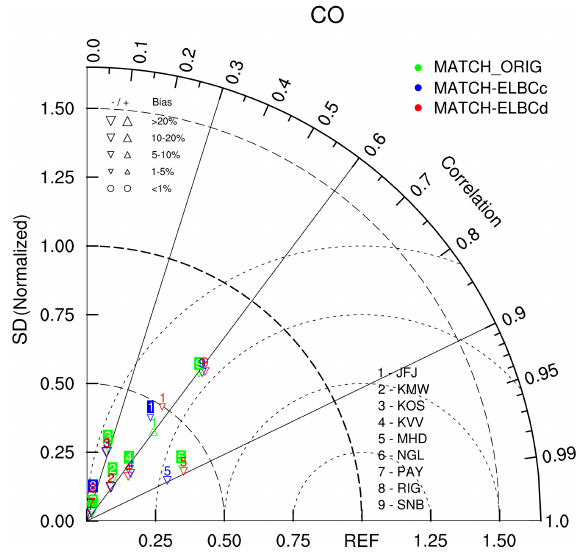
Figure 8. Taylor diagram showing CO statistics for all the chosen GAW stations, for the three MATCH model runs, ELBCd as red, ELBCc as blue and ORIG as green, with statistics from 2006 to 2012. The correlation is given by the cosine angle from the horizon- tal axis, the root mean square error corresponds to the distance from the “REF” indicator on the x axis, the ratio between the variances of the model and the measurements, here referred to as the nor- malised standard deviation and are represented by the radius or dis- tance from the origo and the bias is symbolised next to each marker. Standard deviations larger than 1.75 are represented with their stan- dard deviation/correlation as numbers underneath the diagram. The bias symbols are indicated in the list to the top left.